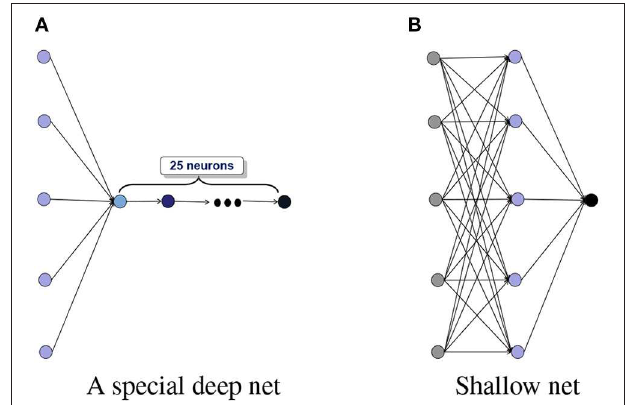
FIGURE 1 | Deep nets vs. shallow nets. (A) A special deep net. (B) Shallow